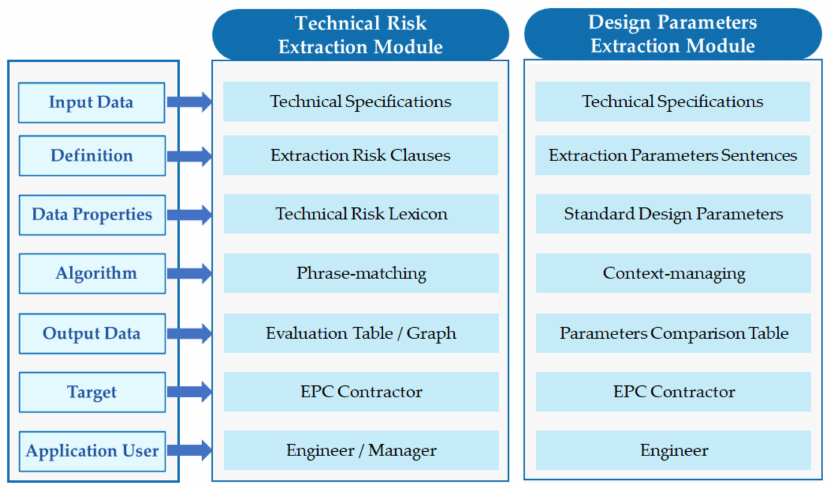
Figure 2. ML-based design risk automatic analysis module